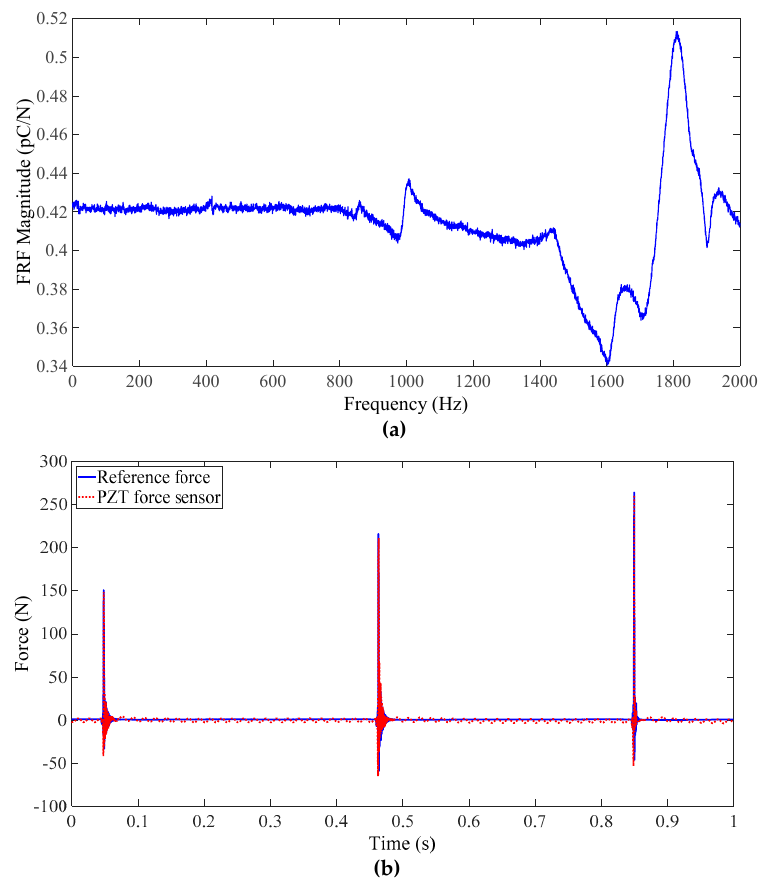
Figure 15. ( a ) Frequency response of the laser-sintered flexible PZT film–SS plate; ( b ) force response of the laser-sintered PZT film.